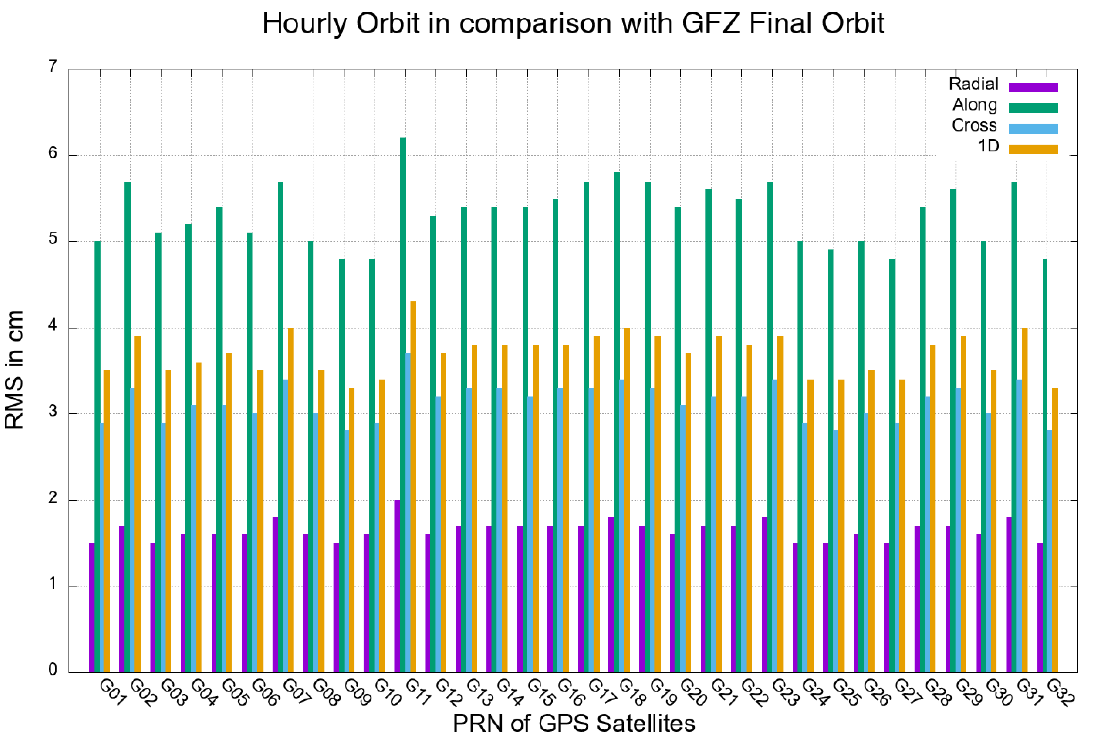
Figure 4. Mean RMS in the RAC components and 1-D of GPS satellites in comparison with GFZ final orbit.